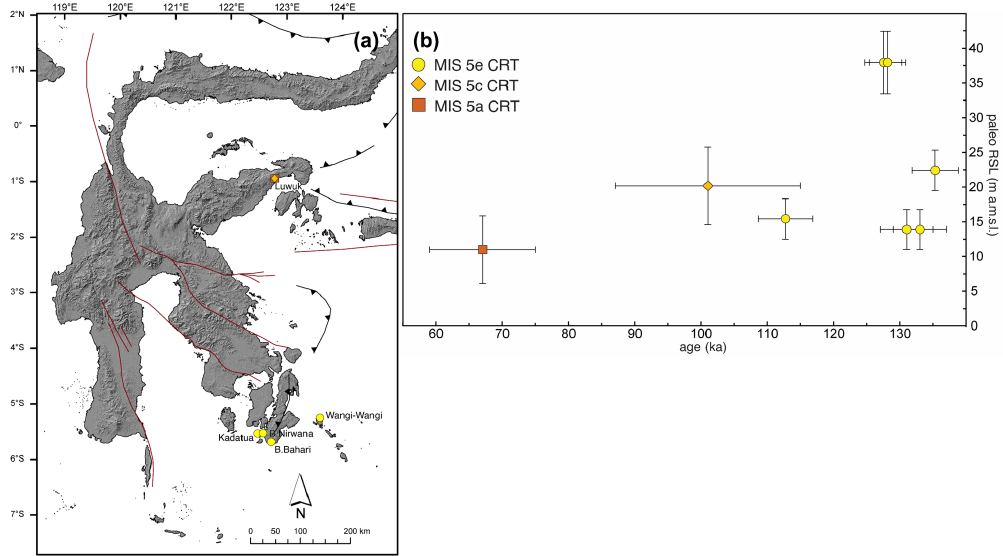
Figure 5. RSL proxies and age–elevation plot of dated corals in Sulawesi. (a) Location map of the six RSL proxies screened in this study (four of which are MIS 5e from southeast Sulawesi; the remaining two points are of MIS 5a and MIS 5c and are from Luwuk). Also shown are the names of the study sites mentioned in the original publications. (b) Age–elevation plot of all the eight coral samples dated using U-Series. Digital elevation model sourced from ASTER GDEM V003 (NASA/METI/AIST/Japan Spacesystems and U.S./Japan ASTER Science Team,